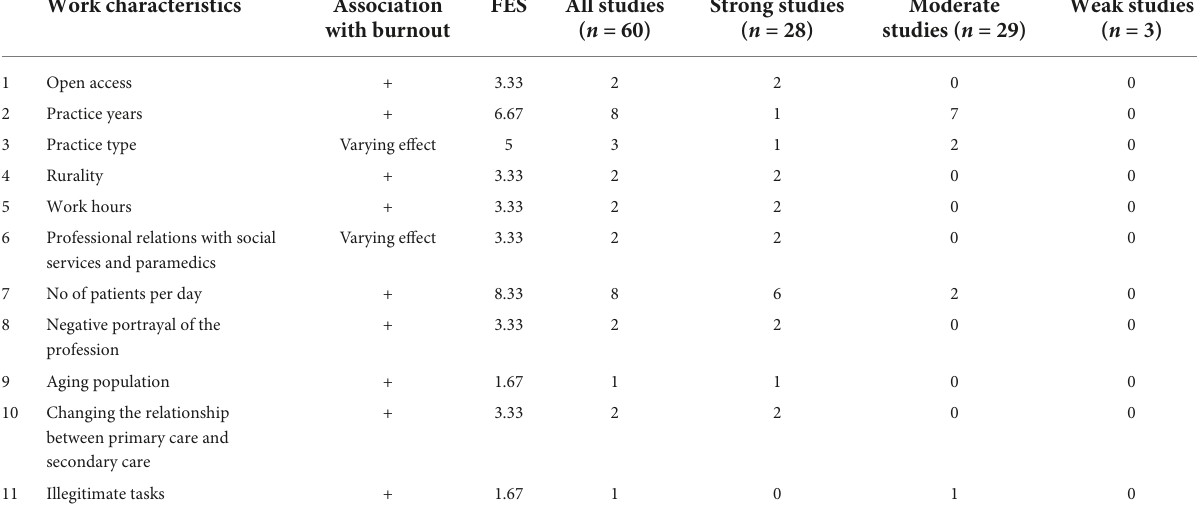
TABLE 4 Study outcomes work